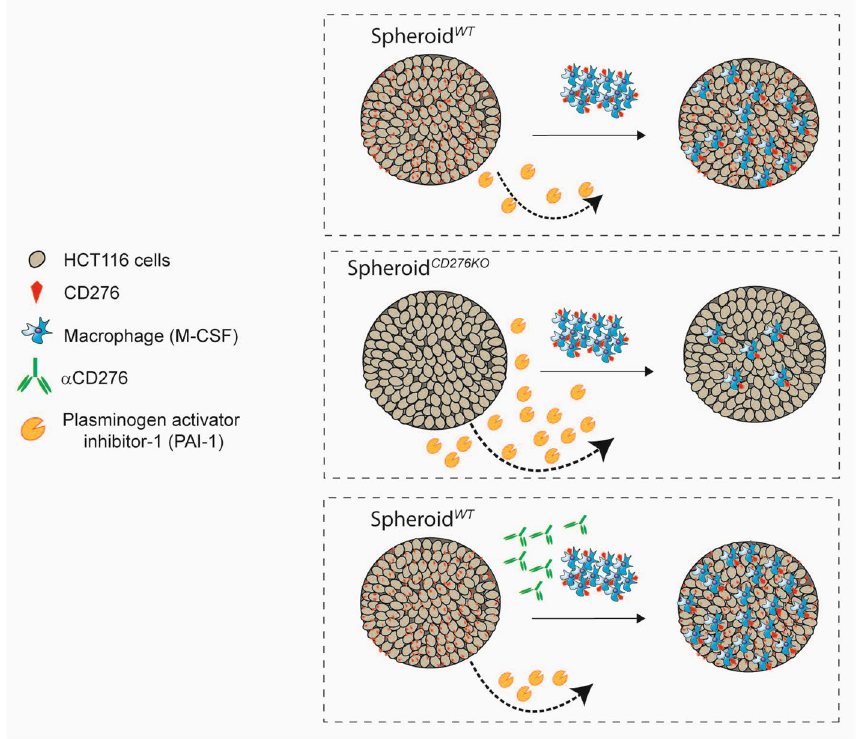
Figure 6. Graphical summary of the highlights. CD276 expression on tumor cells is an important player in macrophage recruitment and an upstream modulator for PAI-1 production in tumor